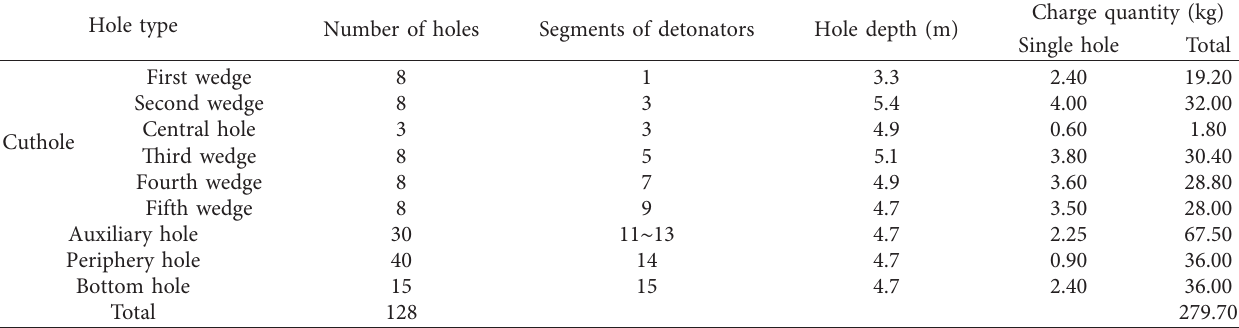
Table 8: Cutting blasting parameters in grade III rocks [32].